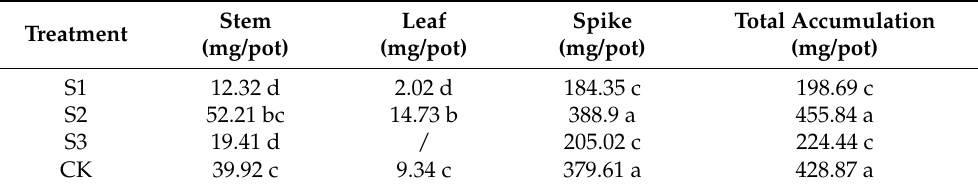
Table 8. 13 C content of each organ of the plant under different source bank treatments at wheat maturity. Treatment